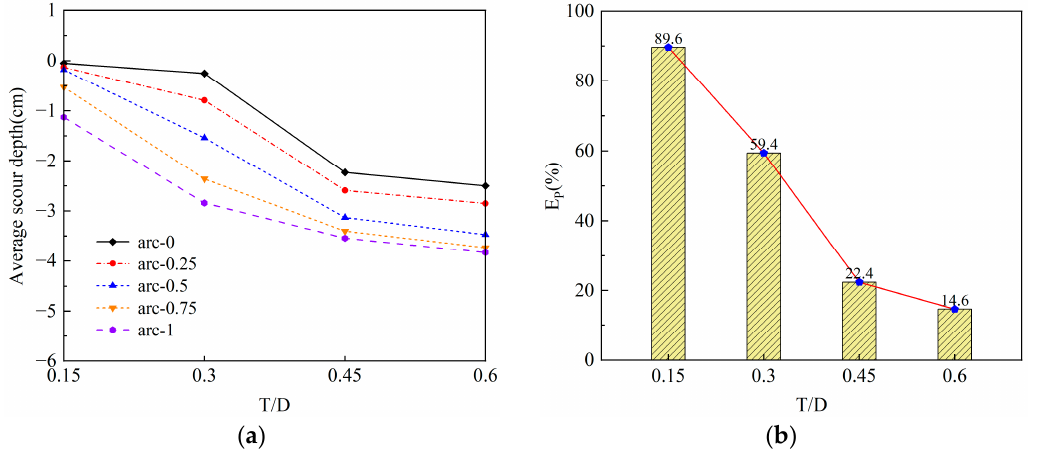
Figure 17. ( a ) Variation of average scour depth with the thickness of the collar . ( b ) Variation of reduction efficiency of the collar with the thickness of the collar.